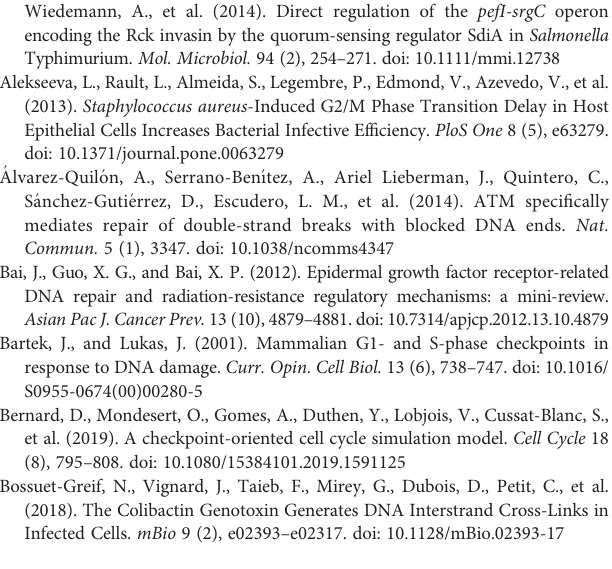
SUPPLEMENTARY FIGURE 3 | Representative DNA histograms from Rck- infected and uninfected cells. HCT116 cells were infected with either MC-RckGFP or MC-GFP strain for 1 h (MOI of 100). At the indicated times, the DNA content was analyzed for 20,000 non-sorted (A) or sorted (cells with internalized bacteria (GFP+) and cells without internalized bacteria (GFP-) (B) events using fl ow